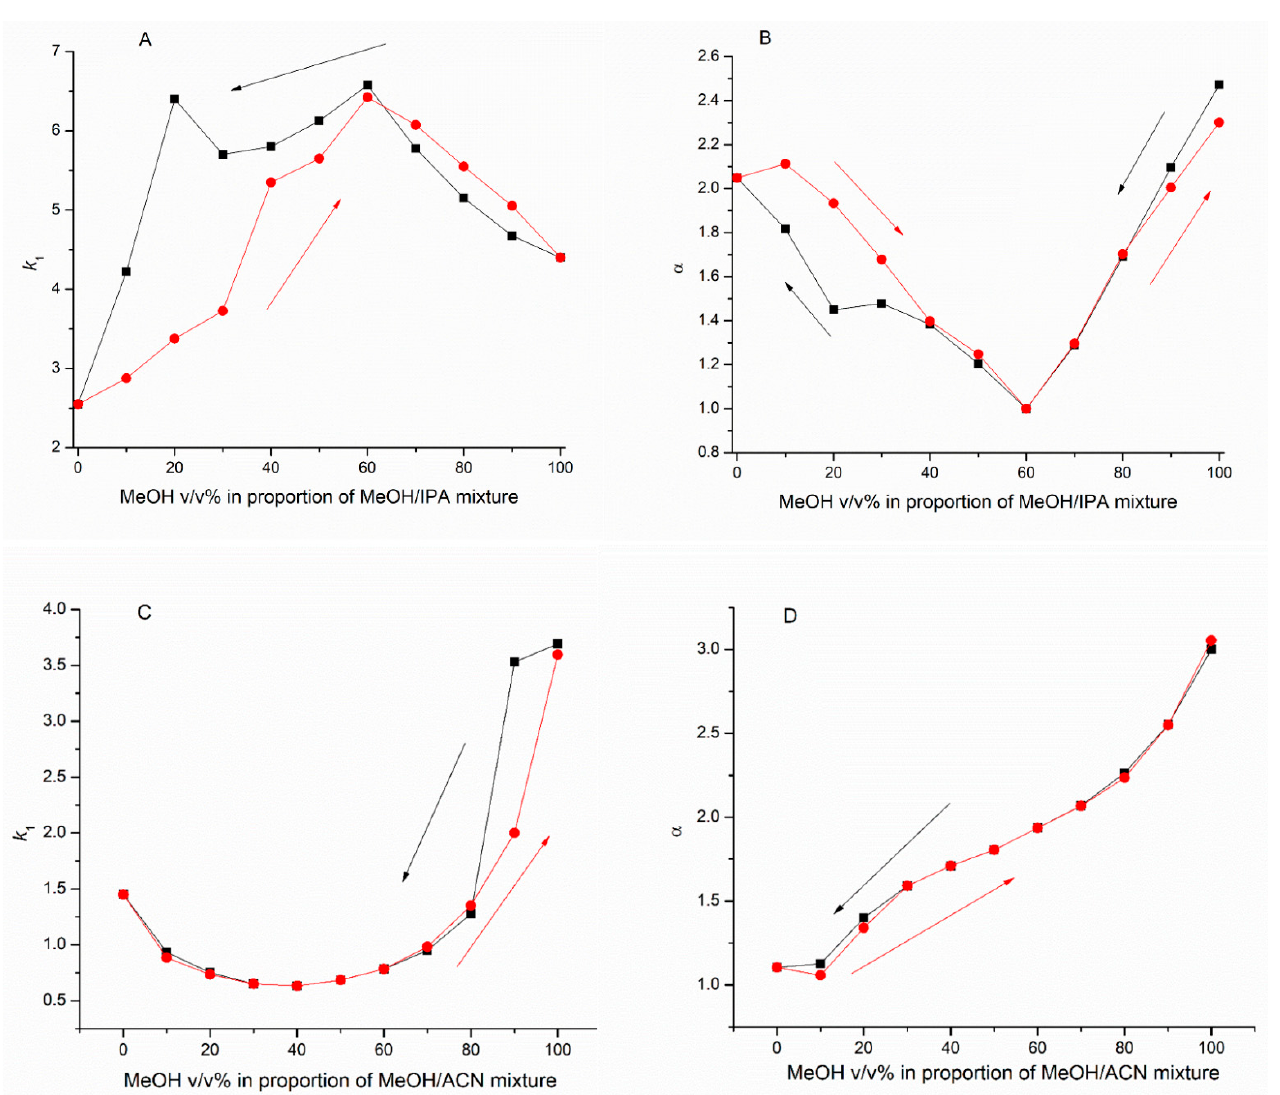
Figure 5. Some representative graphs of retention factor/separation factor vs. eluent composition ( A ): Retention factor of S- THAL in different MeOH/IPA compositions on Chiralpak AD column, ( B ): Separation factor of THAL enantiomers in different MeOH/IPA compositions on Chiralpak AD, ( C ): Retention factor of S- THAL in different MeOH/ACN compositions on Chiralpak AD column, ( D ): Separation factor of THAL enantiomers in different MeOH/ACN compositions on Chiralpak AD.